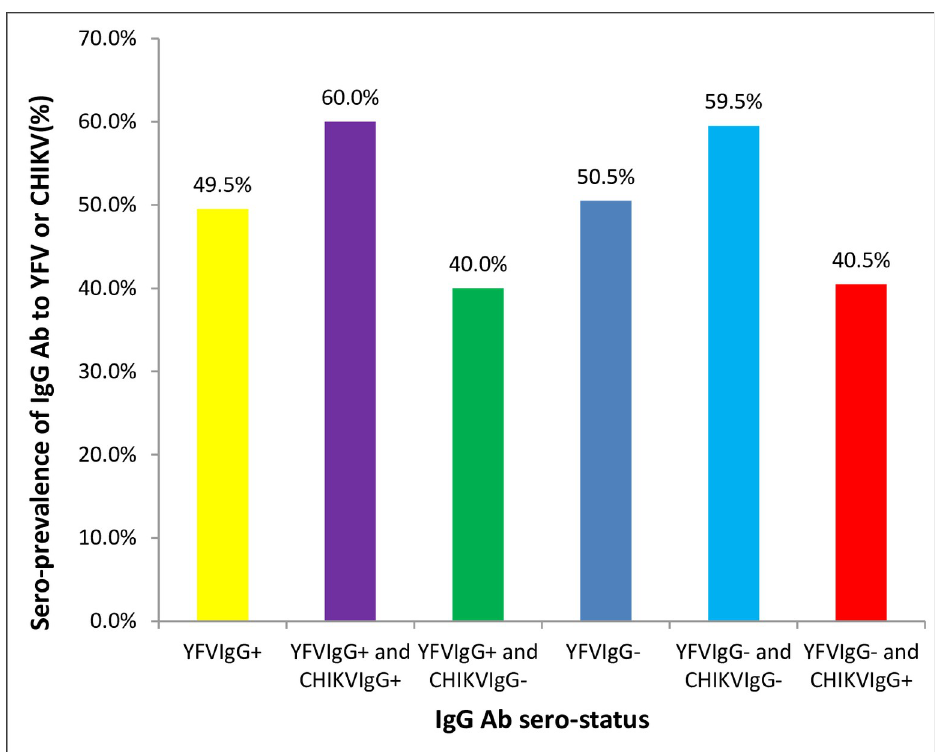
Fig 3. Sero-prevalence of IgG antibody against CHIKV among YFV IgG antibody sero-positive and sero-negative participants.